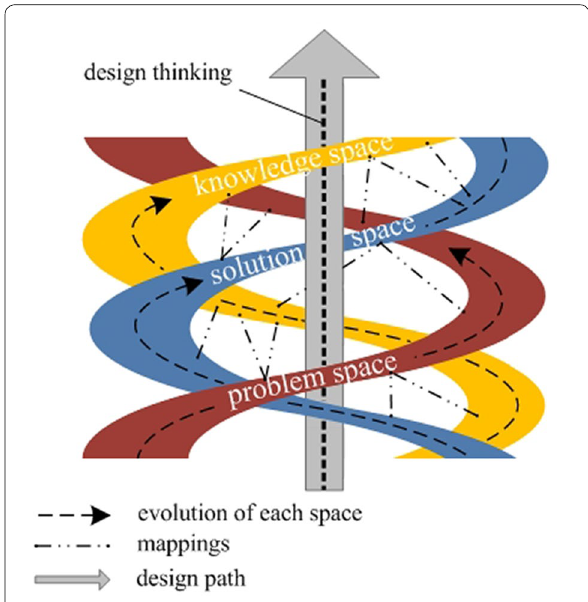
Figure 4 Spiraling iterative design process